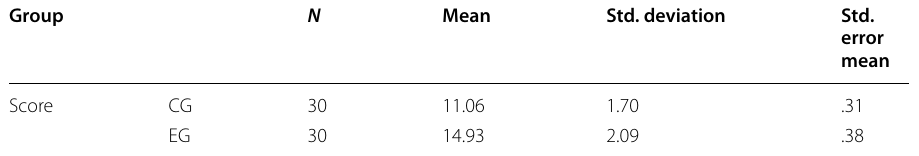
Table 3 Accuracy post‑test descriptive